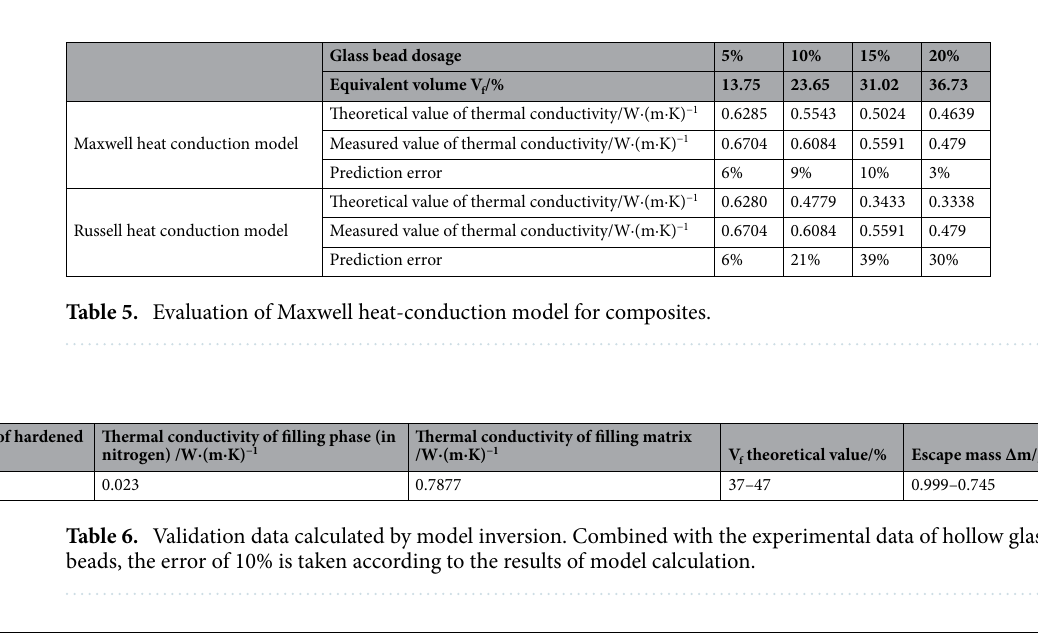
Table 6. Validation data calculated by model inversion. Combined with the experimental data of hollow glass beads, the error of 10% is taken according to the results of model calculation.